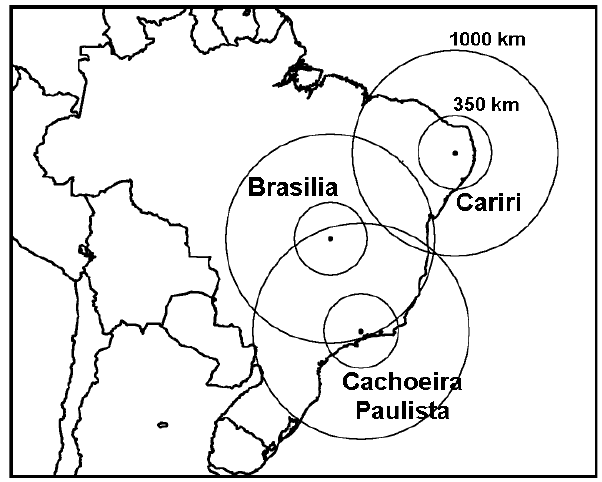
Fig. 1. Map of Brazil showing the location of the three camera sites; near Brasilia (14.8 ◦ S, 47.6 ◦ W), at Cariri (7.4 ◦ S, 36.5 ◦ W) and Cachoeira Paulista (22.7 ◦ S, 45.0 ◦ W). The circles indicate the nominal fields of view of the all-sky imagers used for the meso- spheric OH gravity wave measurements ( ∼ 350km radius), assum- ing an emission height of ∼ 87km, and the thermospheric 630nm depletion measurements ( ∼ 1000km radius) for a peak emission al- titude of ∼ 250km.